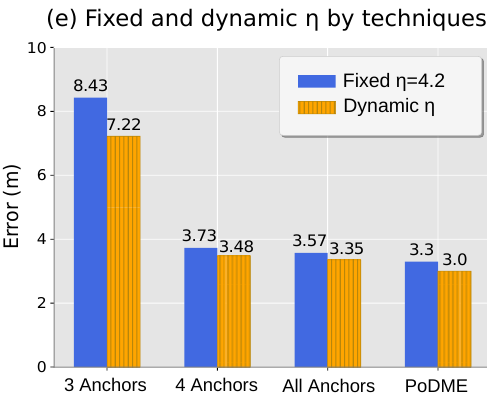
Figure 11. Positioning error